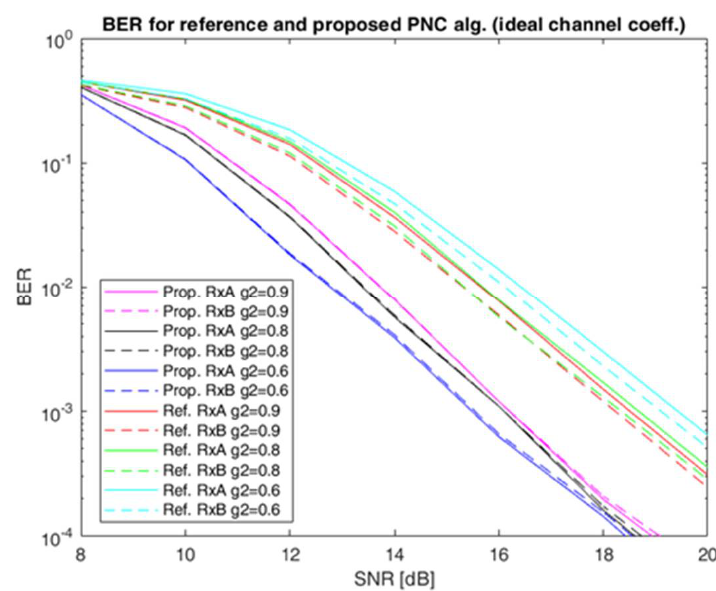
Figure 6. BER on the output of the receiver of terminal A (RxA) and terminal B (RxB) for several values of the weighting coefficient g 2 after two-way data relaying (Prop.—the proposed PNC algorithm, Ref.—the reference PNC algorithm).